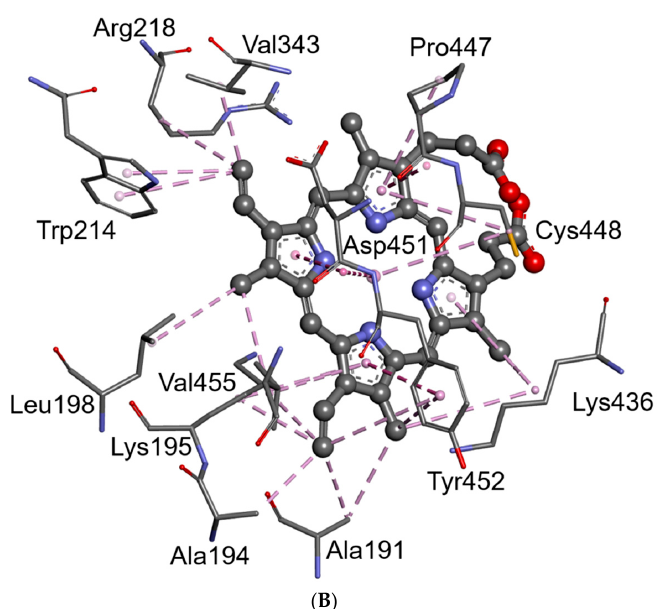
Figure 11. Hydrophobic interactions between the molecules of PpIX and the residues of HSA around the hemin site ( A ) and Sudlow’s Site 1 ( B ). Ligands and residues are shown in the ball and stick and thin stick representation, respectively.